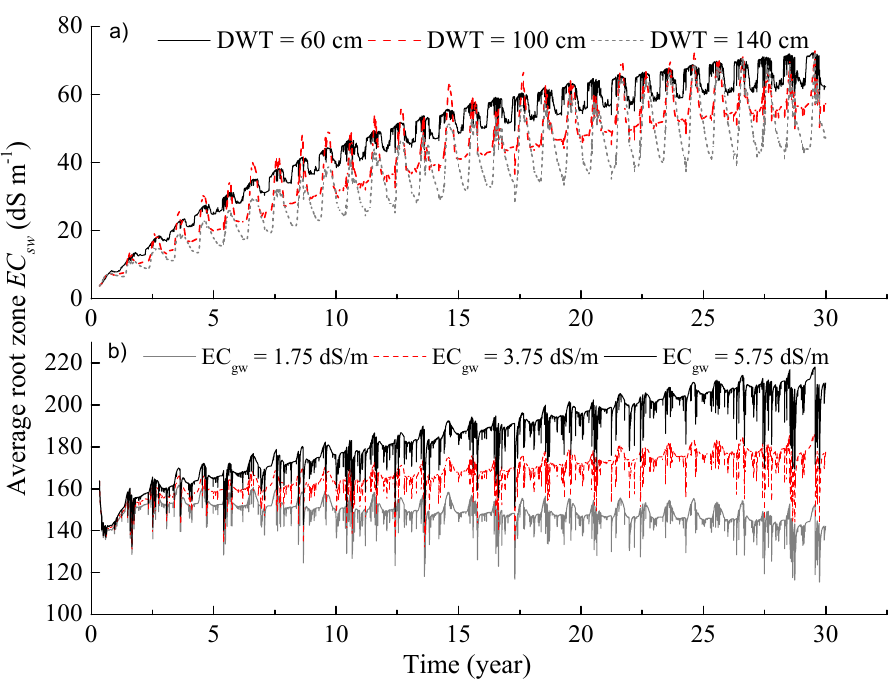
Figure 7. Temporal changes in soil salinity in averaged root zone as affected by ( a ) water table and ( b ) groundwater electrical